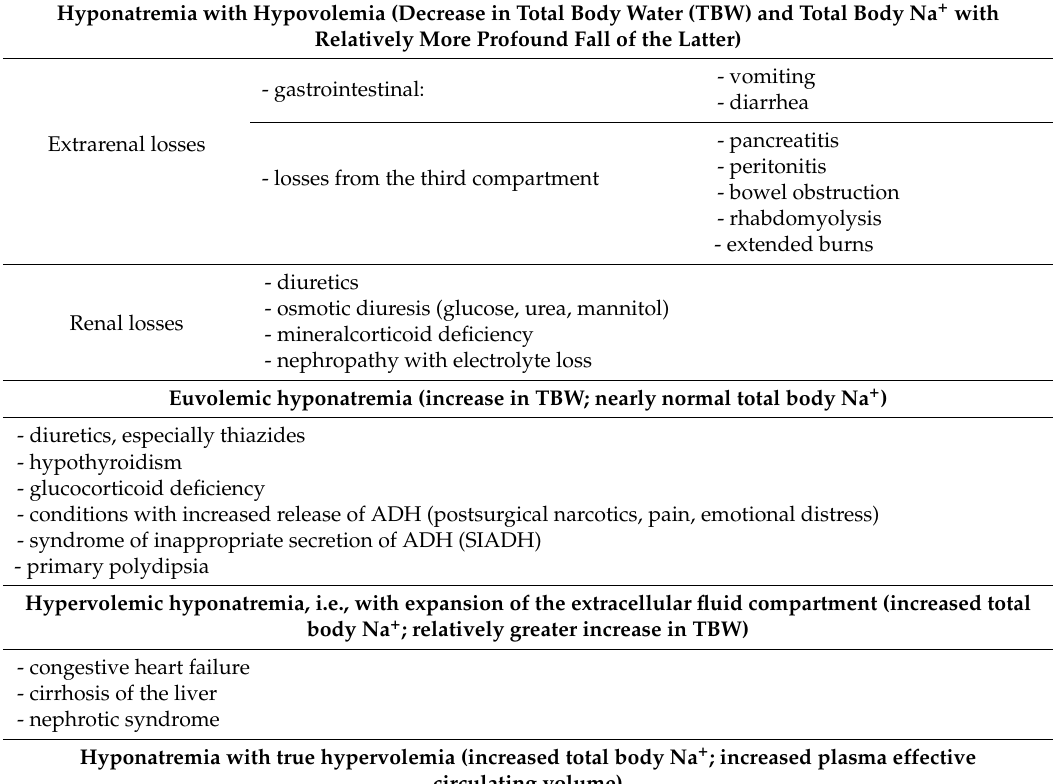
Table 1. Main causes of